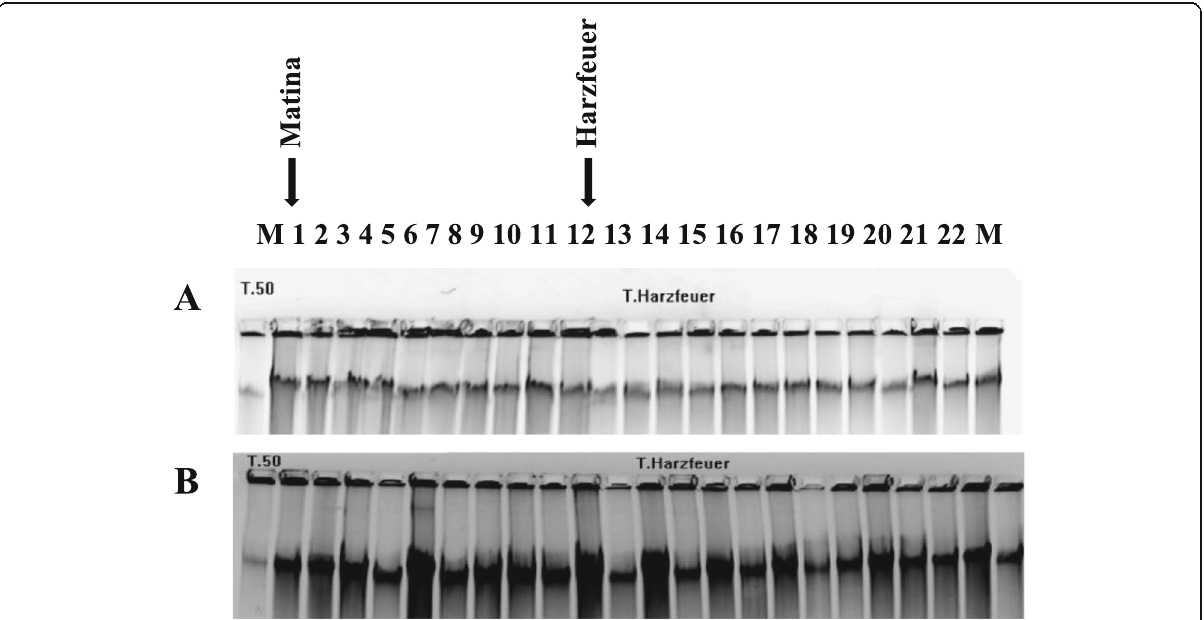
Fig. 1 Total DNA of A. endophytic Beauveria bassiana (BbC1) and B. Metarhizium anisopliae (M150) in on agarose gel in two tomato varieties. 1 st and last lanes Marker: Lane 1- 11: Total fungal DNA isolated in Matina tomato variety: Lanes 12 to 22: Total DNA isolated from Harzfeuer tomato